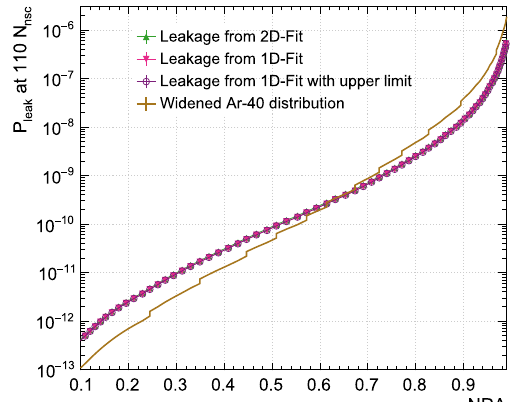
Fig. 7 A study of three effects that lead to systematic uncertainties on the leakage probabilities. The green up-triangles show the nominal leakage probability for F nsc prompt from the 2D fit (the curve is the same as in Fig. 5). The pink down-triangles use the results from the 1D fit instead. The purple boxes are obtained with the 1D fit where the upper fit limit was reduced from 0.6 to 0.55 to exclude bins with fewer than 10 events. The points overlap, indicating that the fit procedure does not significantly change the leakage predictions. The brown curve uses an 40 Ar distribution modified to account for energy resolution differences between MC and real data